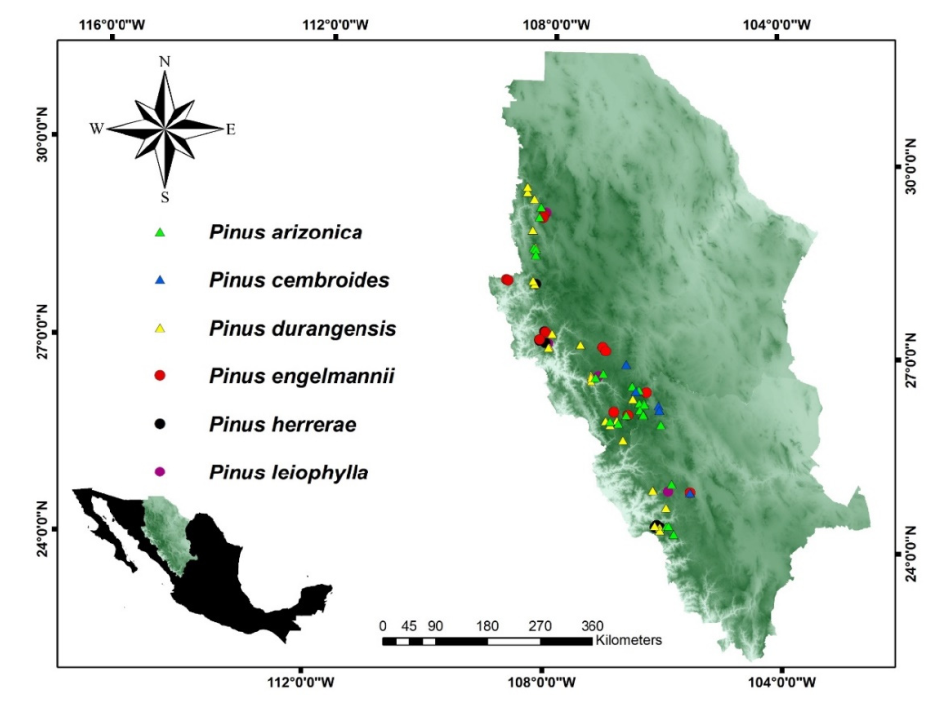
Figure 1. Location of the 80 populations of Pinus arizonica, P. cembroides, P. durangensis, P. engelmannii, P. herrerae and P. leiophylla in the Sierra Madre Occidental in Durango and Chihuahua, Mexico. Needles were sampled from 877 Pinus arizonica (PA) trees, 174 P. cembroides (PC) trees, 908 P. durangensis (PD) trees, 420 P. engelmannii (PE) trees, 280 P. herrerae (PH) trees and 140 P. leiophylla (PL) trees. The sampled populations were grouped into two categories: